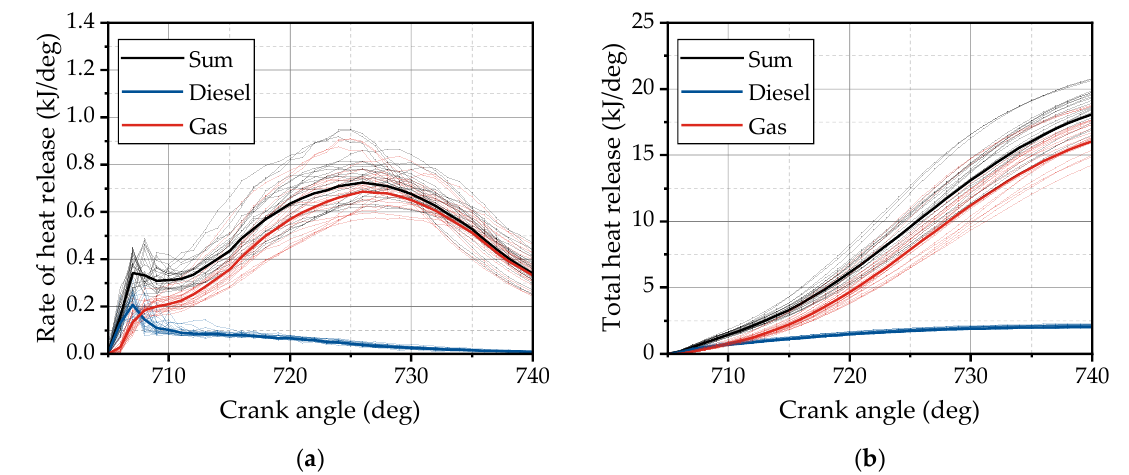
Figure 10. ( a ) Rate of heat release and ( b ) total heat release divided into the share of diesel and gas for the single LES cycles and the ensemble average.